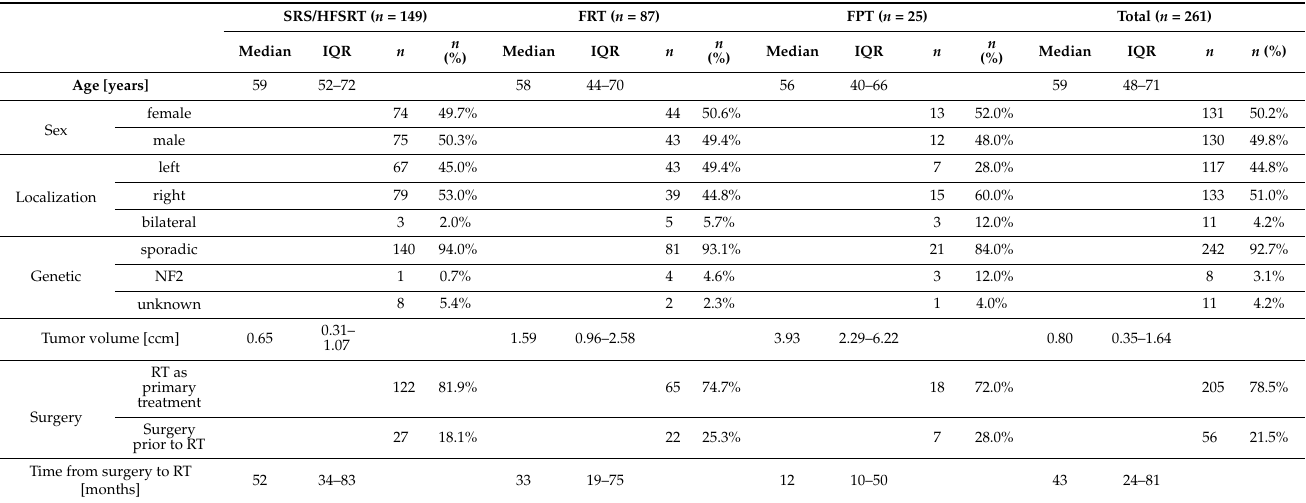
Table 1. Patient characteristics by treatment